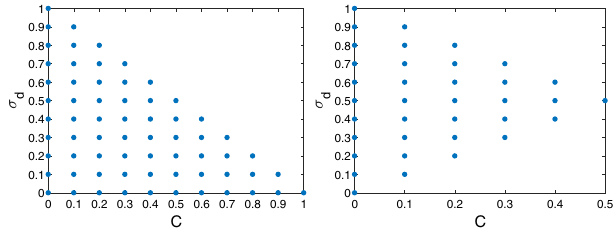
FIG. 8. Two sets of reference points based on different